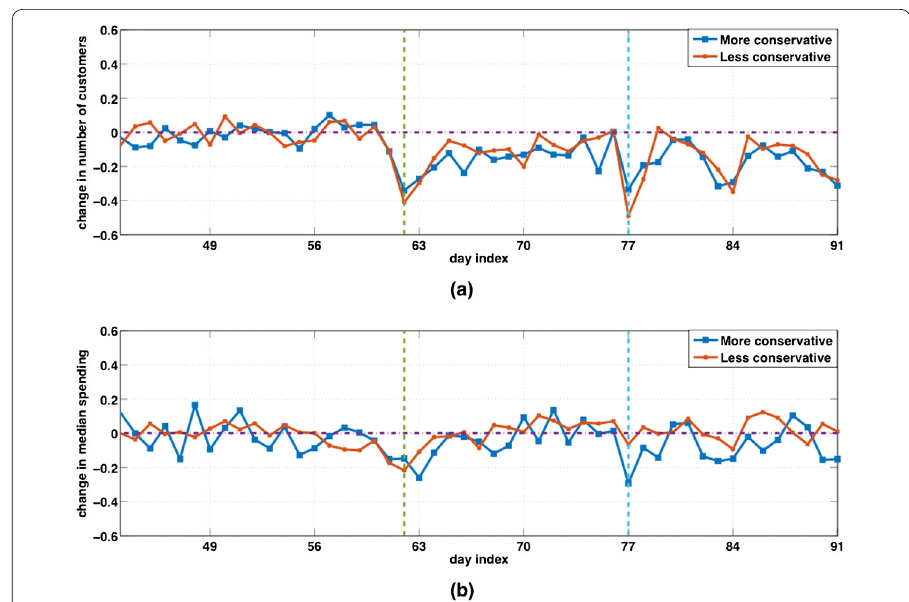
Figure 7 The impact of a series of protest events in neighborhoods of higher political conservatism (blue) and lower political conservatism (red): ( a ) number of customers; ( b ) median spending. The dash-dot purple line indicates zero change, and the dashed green and cyan lines indicate Day 62 and Day 77,